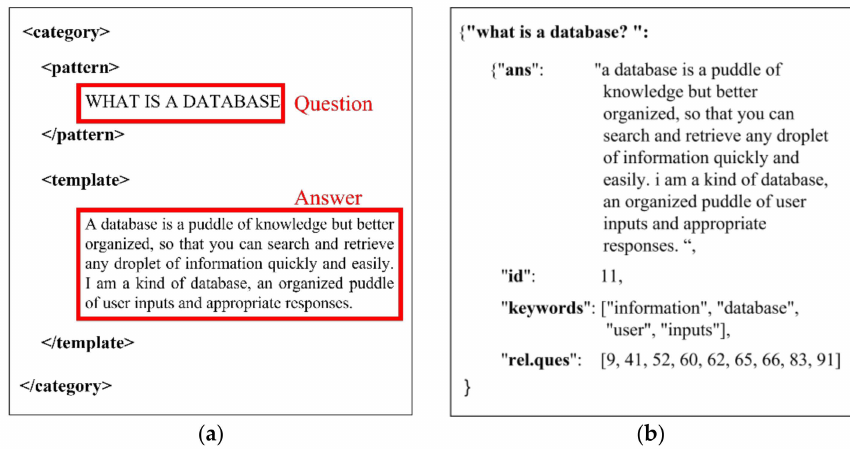
Figure 6. Example of Q&A pair in AIML file ( a ) and modified Q&A pair ( b